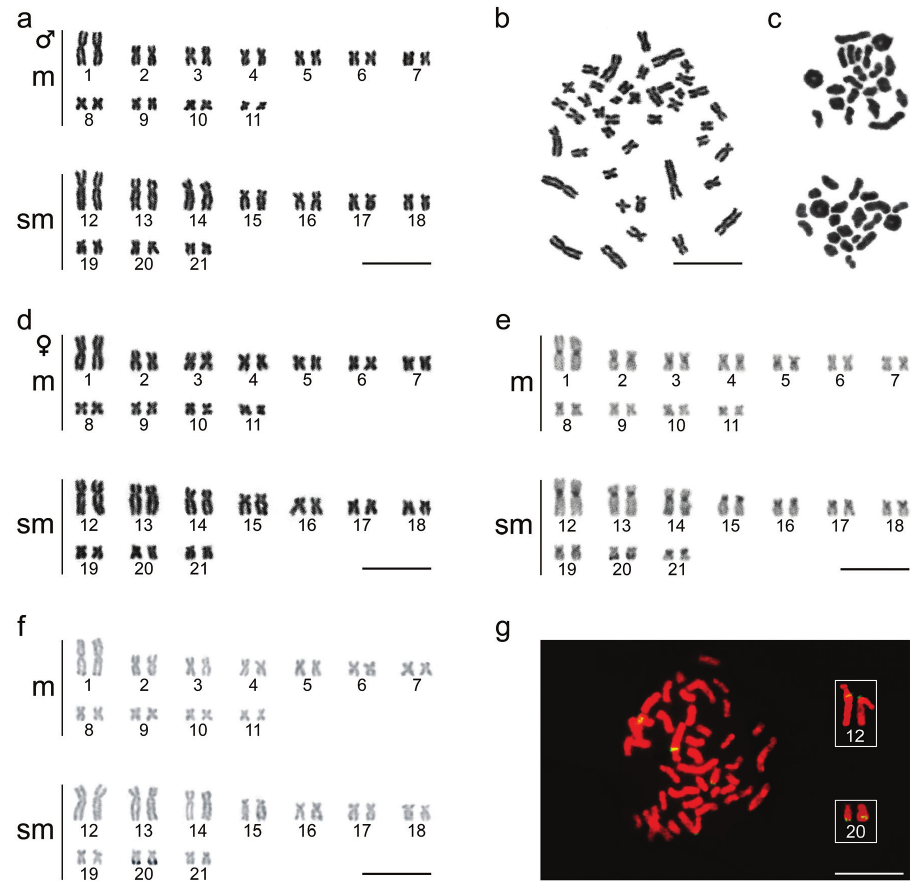
Figure 2. a Male Hoplias malabaricus karyotype with conventional Giemsa staining (karyomorph A) b Metaphase corresponding to karyotype showed in ( a ) c Male meiotic metaphase showing formation of 21 bivalents d Female Hoplias malabaricus karyotype (karyomorph A) e C-banding karyotype exhibiting centromeric staining in most of chromosomes and telomeric signal in pairs number 14 and 20 f Ag-NOR banding karyotype displays telomeric signal in chromosome pair 20 g FISH with 18S rDNA probes labe- ling two chromosomic pairs, numbers 12 and 20 (boxed). Bar = 5